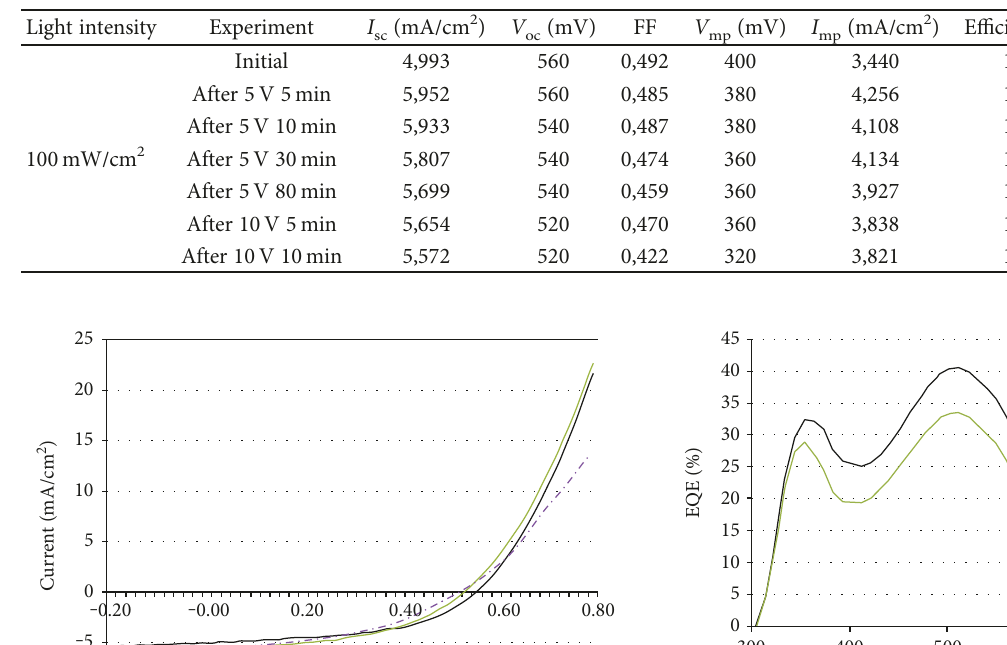
Table 4: Device 5 fi nger 3 time-dependent voltage degradation.